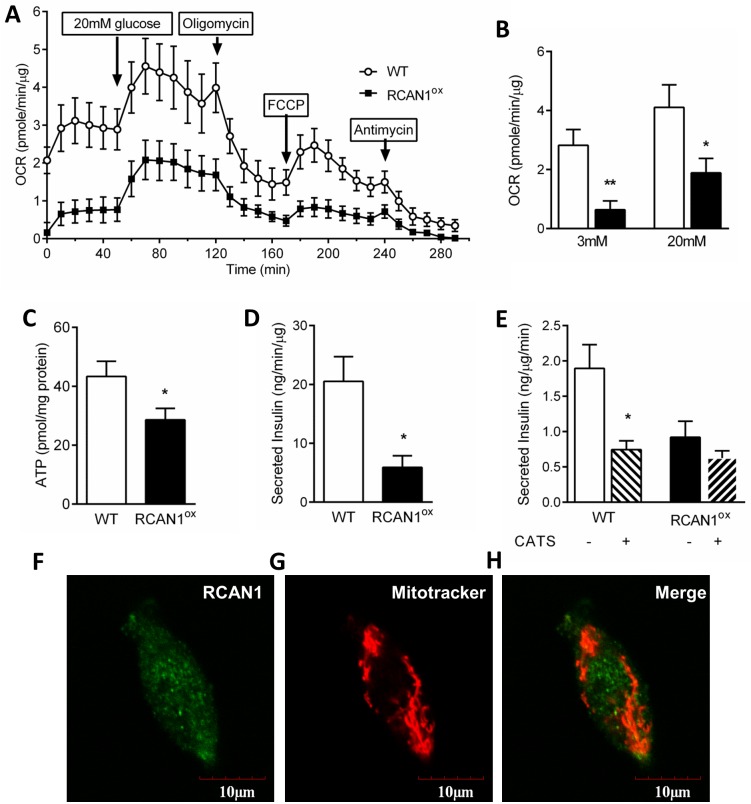
Mitochondrial respiratory output is reduced in RCAN1ox islets.(A) Oxygen consumption rate (OCR) in WT (n = 5) and RCAN1ox (n = 6) islets under various conditions. (B) OCR in 3 mM or 20 mM glucose. (C) Islet ATP levels (n = 7 WT and n = 4 RCAN1ox). (D) Methyl-succinate-induced (10 mM) insulin secretion (n = 4/group). (E) Effect of carboxyatractyloside (CATS, 200 μm) on insulin secretion in response to 20 mM glucose (n = 4–7). Immunocytochemical labelling of (F) RCAN1, (G) mitochondria (Mitotracker Red) and (H) both in MIN6 cells. *p < 0.05, **p < 0.01.